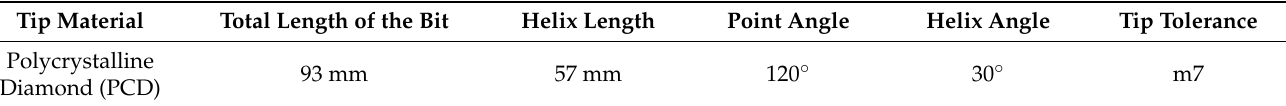
Table 2. Main features of the drill